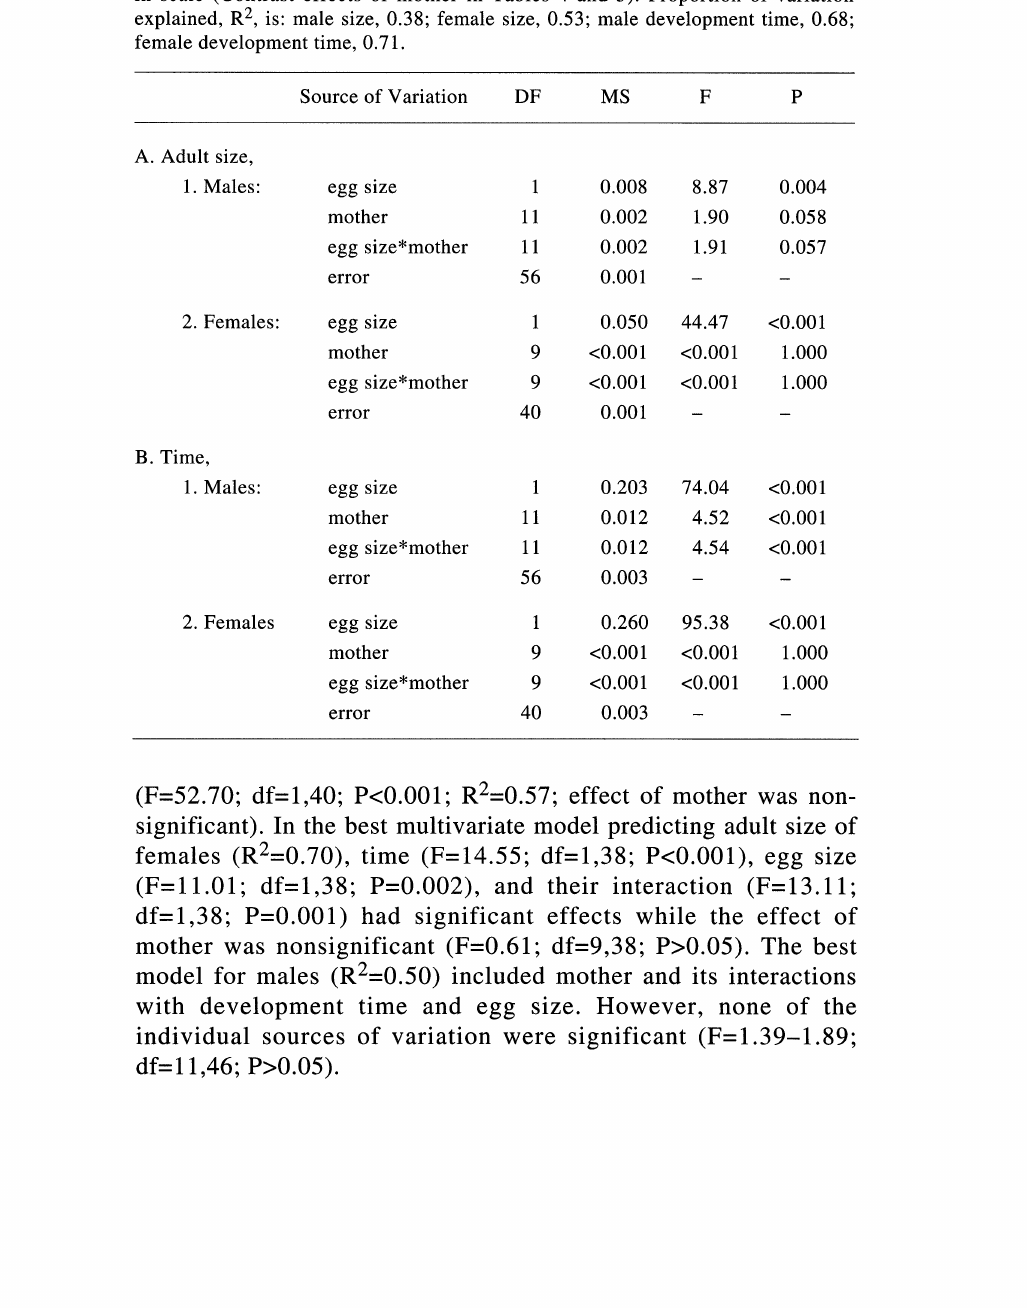
Table 4. ANOVA of effect of egg size and mother on (A) adult size and (B) development time in (1) males and (2) females. For each mother, all measures have been converted to relative values by dividing by the mean of the mother. The effect of relative measures is to de-emphasize between-mother effects due to differences in scale (Contrast effects of mother in Tables 4 and 5). Proportion of variation explained, R 2, is: male size, 0.38; female size, 0.53; male development time, 0.68; female development time,